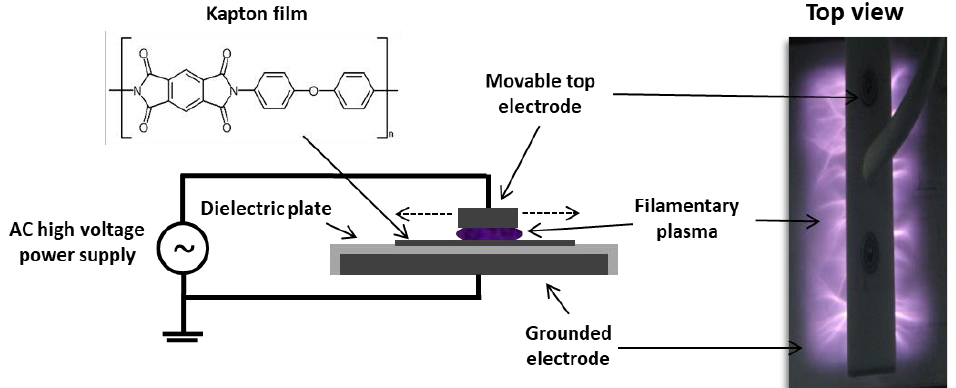
Figure 1. Schematic of the dielectric barrier discharge (DBD) system used for the treatment of Kapton and photography of DBD plasma.